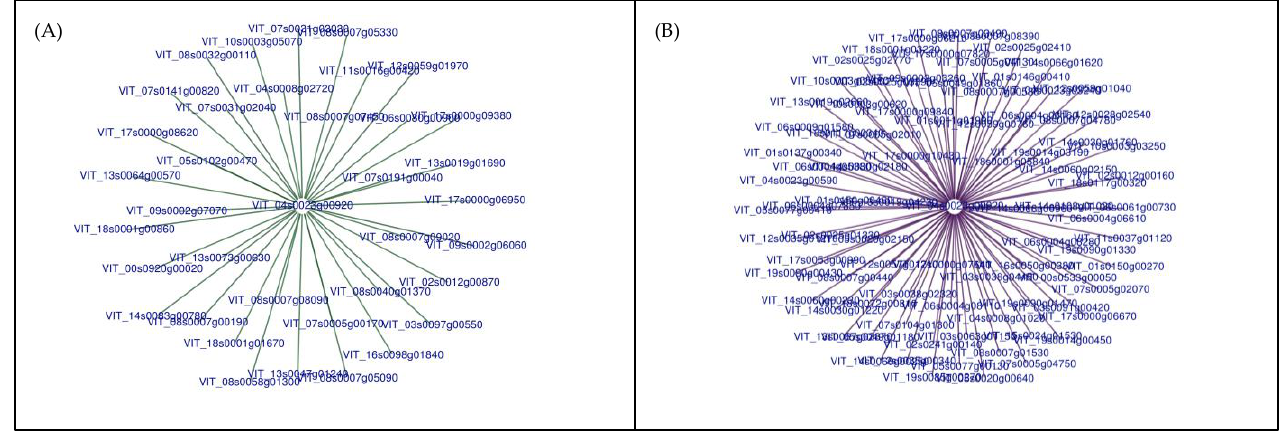
Figure 6. Two networks produced through differential co-expression analysis, one showing a gain in co-expression ( A ) and one showing a loss in co-expression ( B ). The centralized gene is VIT_04s0023g00920, which encodes for a dicer-like protein The transcripts on the exterior are asso- ciated with (a) transcription and translation processes or (b) with metabolite synthesis and energy metabolism.